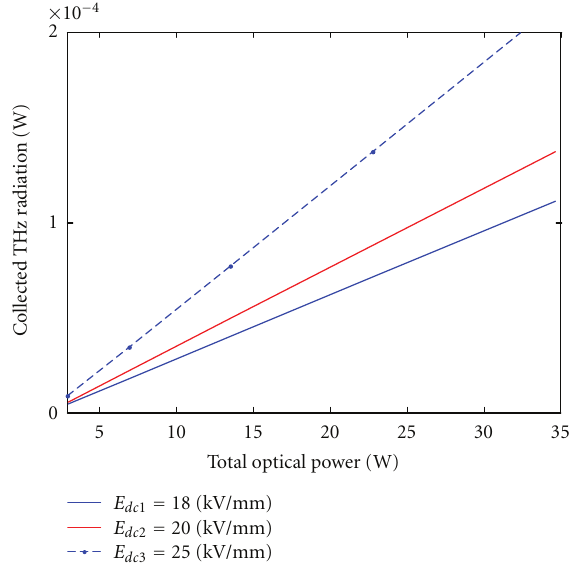
Figure 2: The power of the collected THz radiation utilizing a 5cm diameter lens.